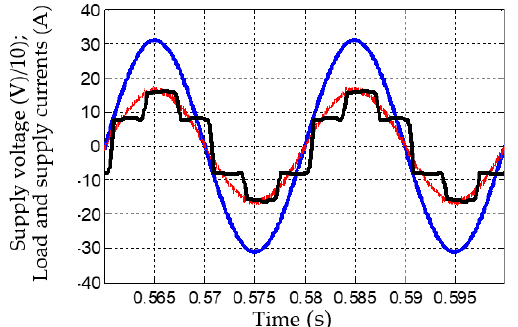
Figure 8. Waveforms of load current (in black), supply voltage (in blue) and supply current (in red) in steady-state regime.